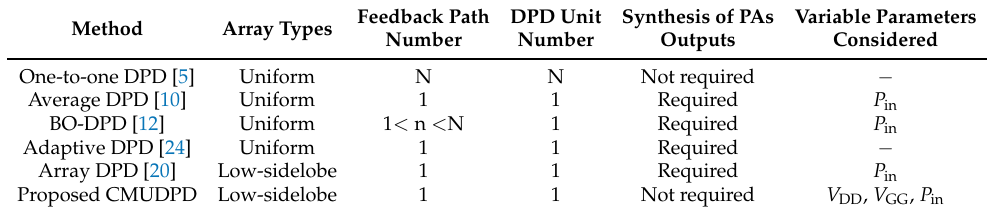
Table 1. The comparison of the proposed solution with the state-of-the art methods. N: number